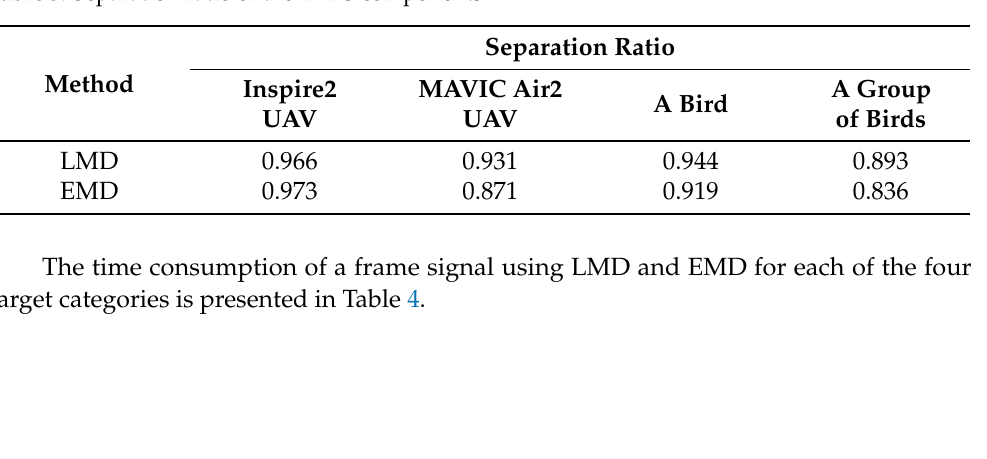
Table 3. Separation ratio of the m-DS